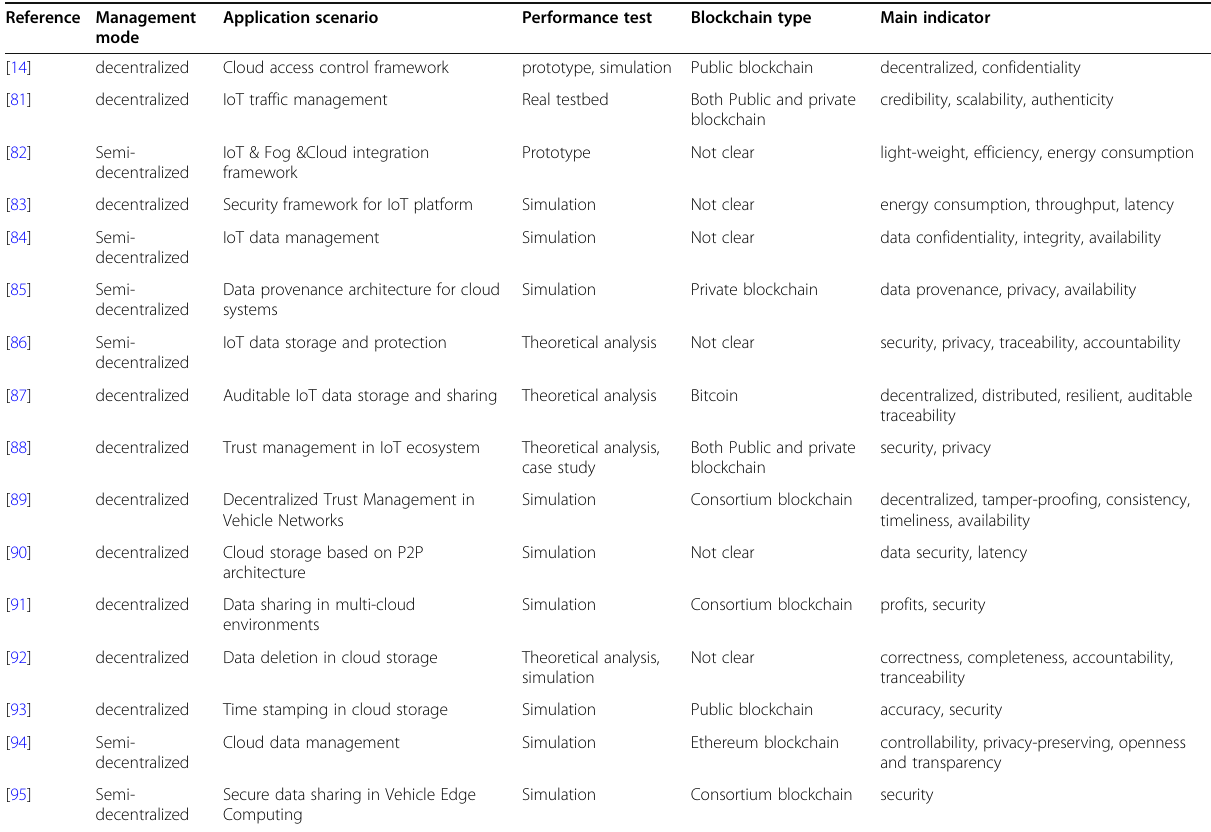
Table 7 Comparison of the applied methodology Reference Management mode